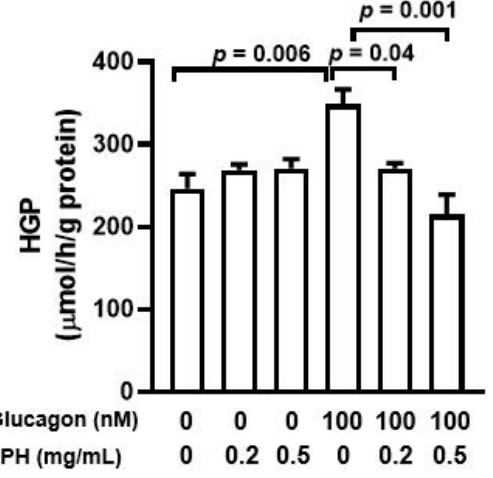
Figure 3. PPH suppressed glucose production in the AML-12 cells. AML-12 cells were cultured in glucose and phenol red-free DMEM containing sodium pyruvate and sodium lactate and pre-treated PPH, followed by the co-treatment with glucagon (100 nM) for 6 h. The concentration of glucose produced by the cells was normalized by the total protein content of the cells. Data are expressed as mean ± SEM of 5 independent experiments.